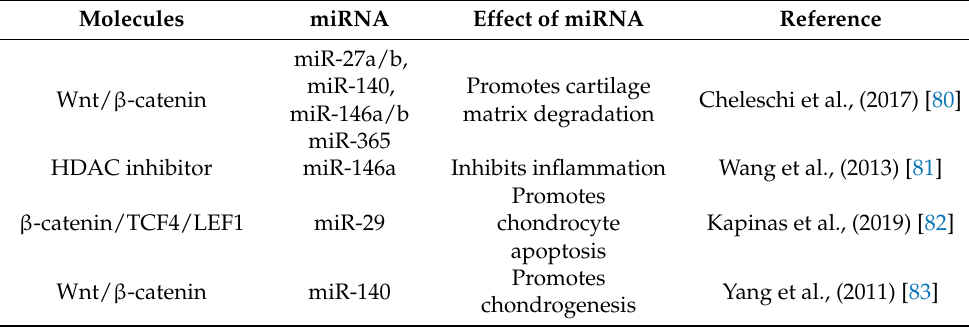
Table 4. miRNAs regulated by canonical Wnt signaling pathways in the pathogenesis of